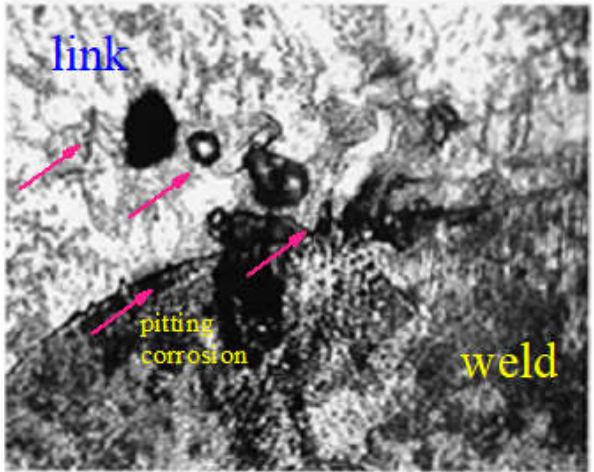
Figure 14. Pitting corrosion of the link/weld interface of the transversal surface in Test 2. Optical examination, magnification 40×. Sample #3.